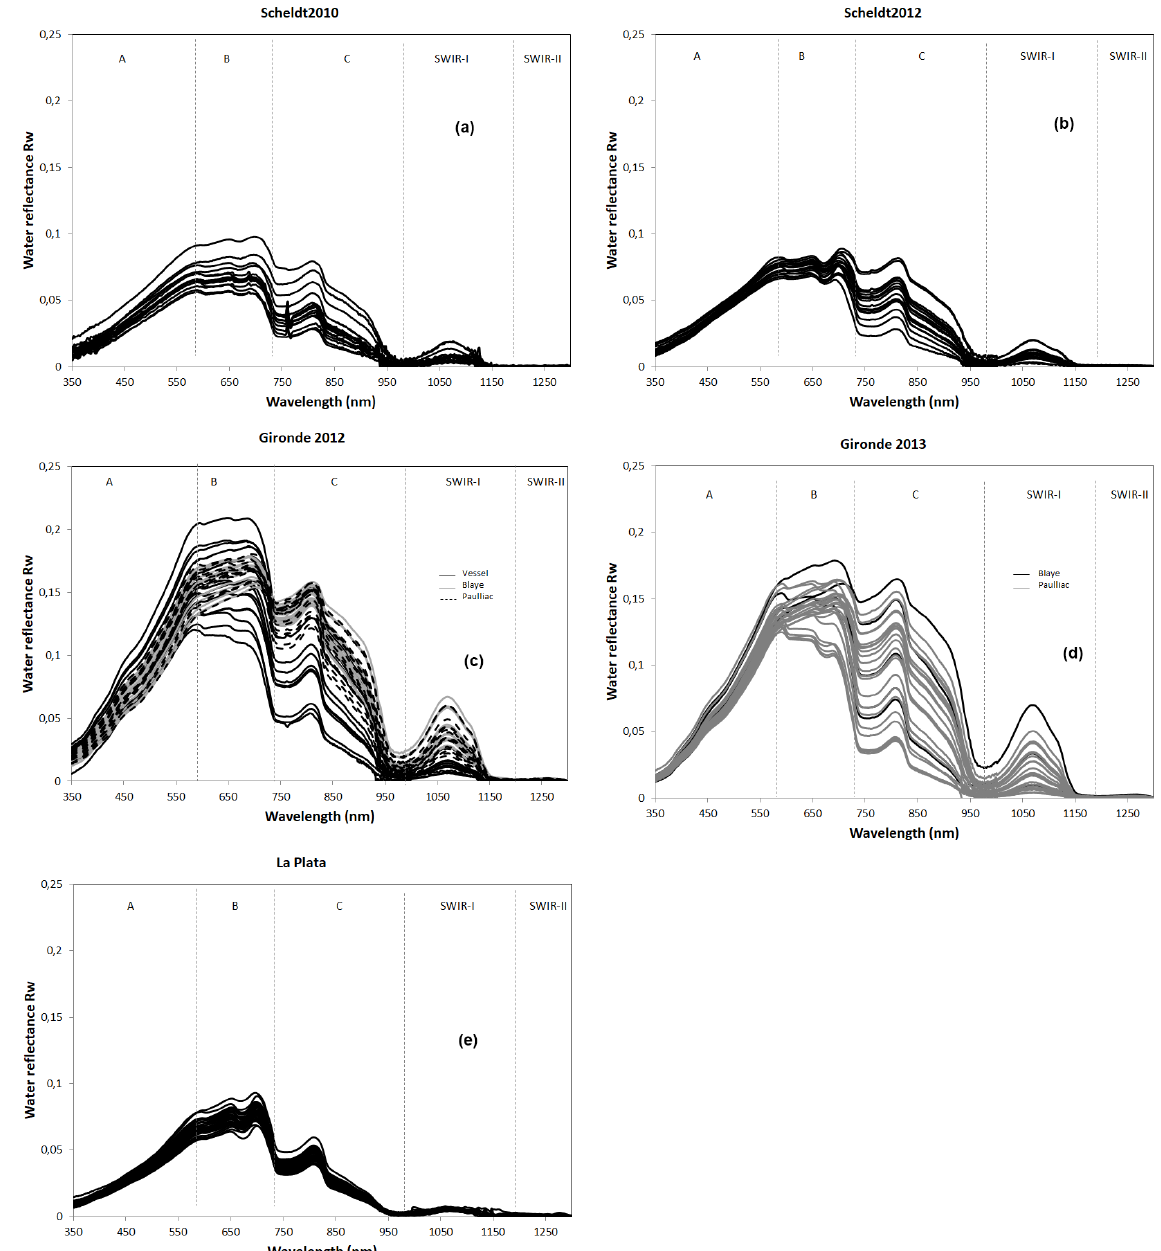
Figure 5. ASD water reflectance for all data